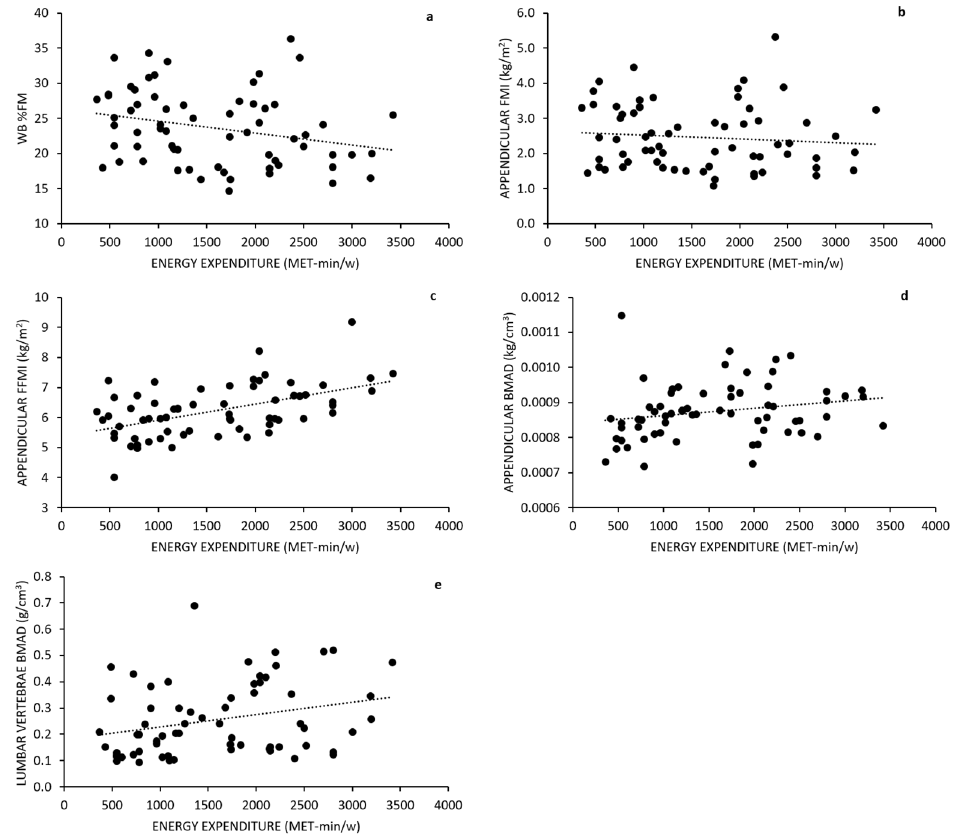
Figure 5. Scatterplot of weekly energy expenditure and percent FM, and stature-adjusted body composition variables in the whole groups of girls (recreational dancers, recreational gymnasts, and physically active controls). Raw correlations were as follows: ( a ) r = − 0.262, p = 0.035; ( b ) r = − 0.097, p = 0.443; ( c ) r = 0.516, p < 0.001; ( d ) r = 0.214; p = 0.087; ( e ) r = 0.353, p = 0.004. For adjusted correlations (r PC ), see text. TBLH, total body less head. WB, whole body; FM, fat mass; FMI, fat mass index; FFMI, fat-free mass index; BMAD, bone mineral apparent density.